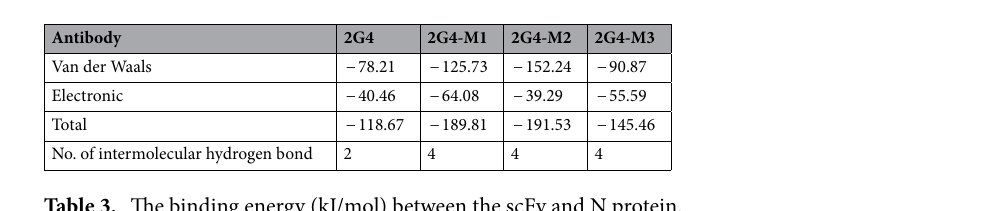
Table 3. The binding energy (kJ/mol) between the scFv and N